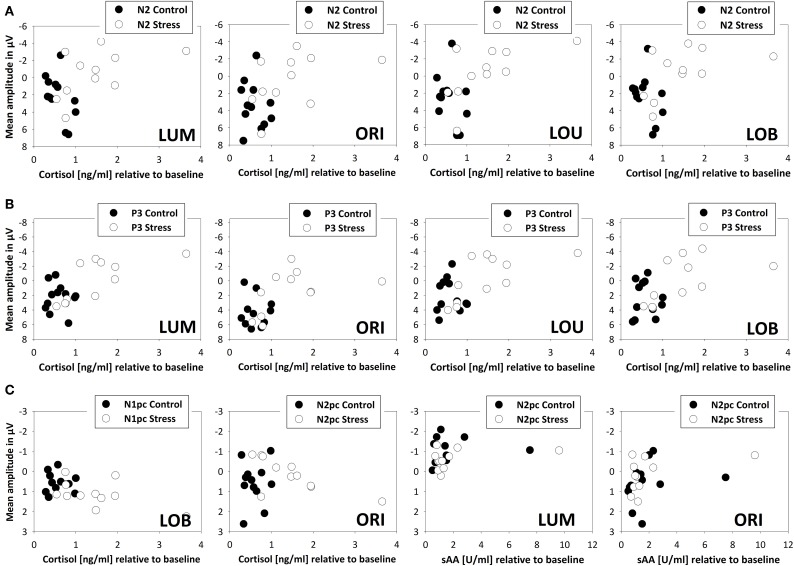
Scatterplot denoting correlations between endocrine measures (salivary cortisol and alpha-amylase) and electrophysiological measures (ERPs and ERLs) for stressed (N = 11, open circles) and control participants (N = 12, filled circles). All scatterplots exclude one participant of the stress group, because of its high absolute and relative cortisol levels. Fronto-central brain activity 20 min after the SECPT/warm water control (+20 min) is indicated by the N2 (A) and P3 (B). Posterior attentional processing, indicated by the N1pc and N2pc is shown in row (C). Reliable correlations between sAA and N2pc were evident directly after the SECPT/warm water control (+3 min) only.